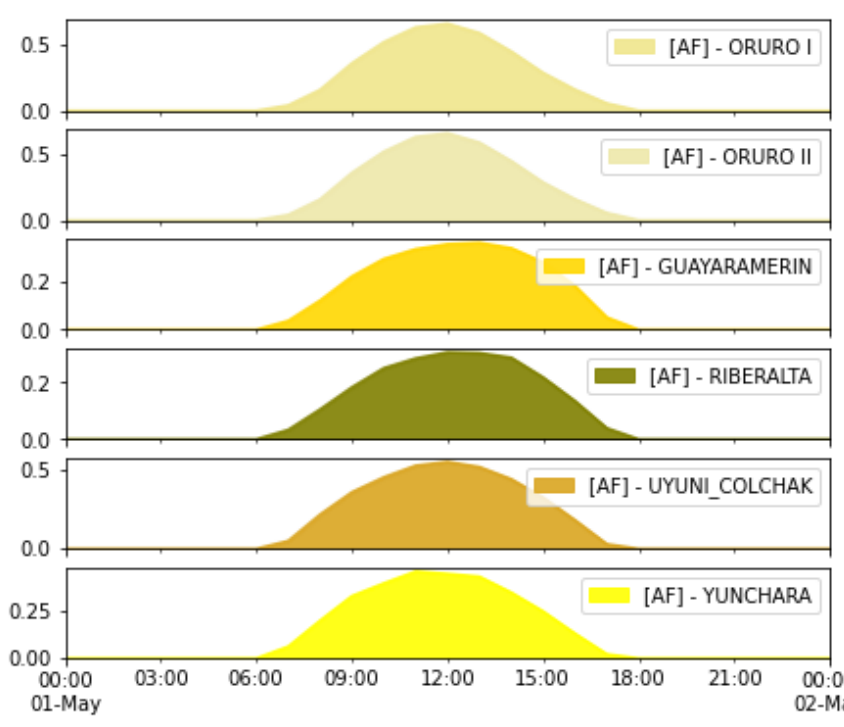
Figure 14. Solar Resources Availability Factor (1 May